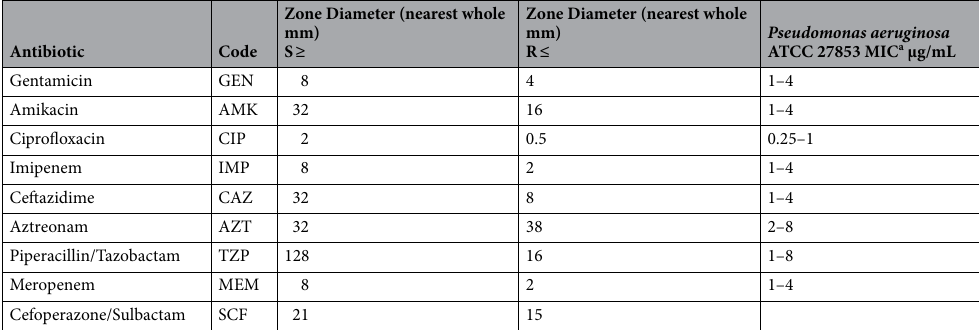
Table 1. Summarization of E-test ® interpretive criteria of MIC for Pseudomonas aeruginosa in accordance with CLSI 2019 23 . a Minimun inhibitory concentration measured in